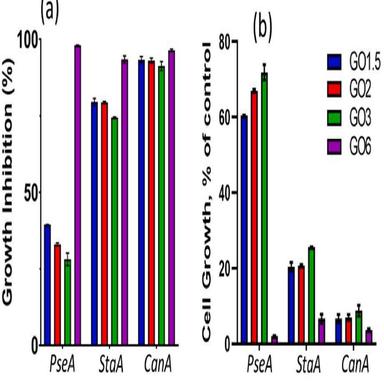
Assessment of Nanomaterials' Impact on Biofilm Formation: (a) The diagram illustrates the percentage of biofilm growth inhibition in microorganisms achieved through nanomaterial treatment. (b) The percentage of biofilm growth observed following treatment with the nanomaterials.